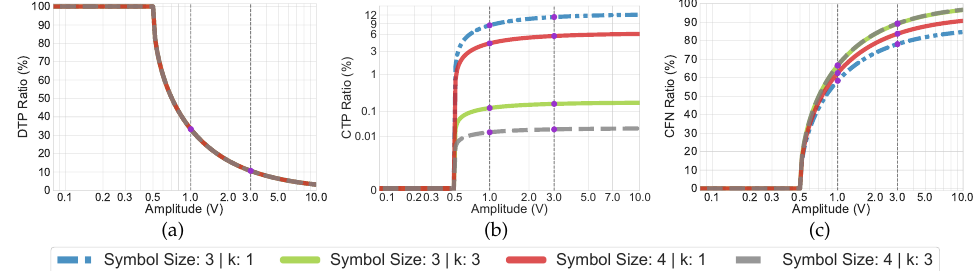
Figure 5. Theoretically calculated DTP, CTP, and CFN ratios at harmonics of the disturbance frequency when f bit is 200